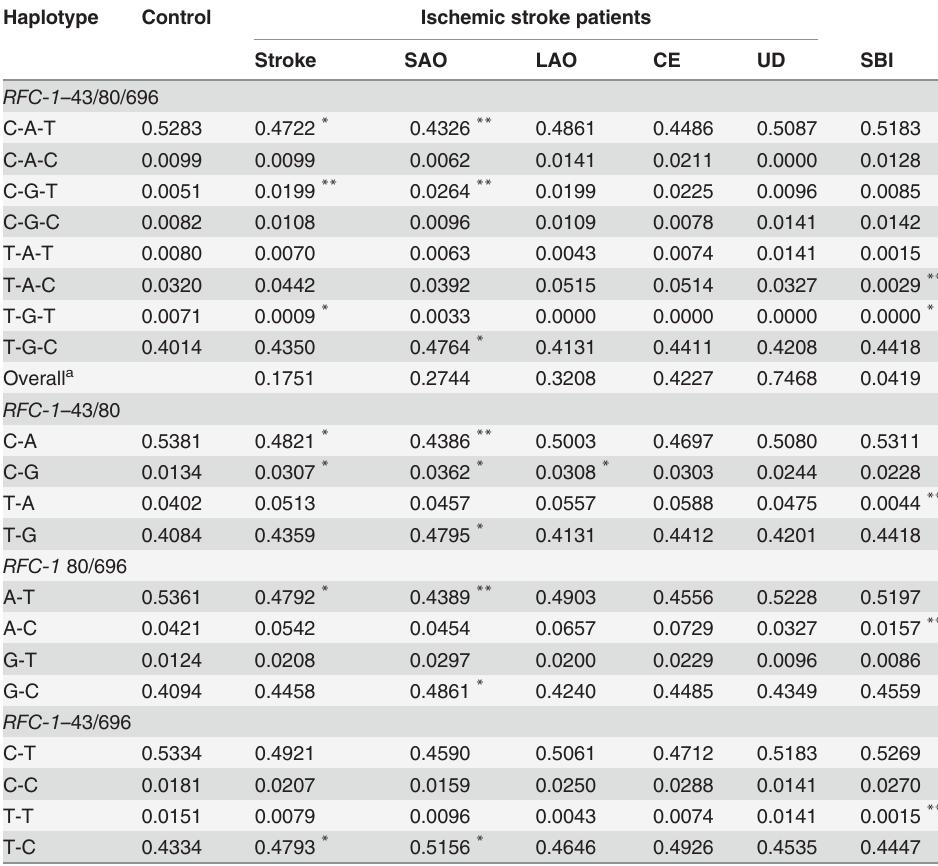
Table 4. The haplotype analysis of the RFC-1 -43C > T, 80A > G, and 696T > C polymorphisms among the ischemic stroke patients, silent brain infarction (SBI) patients, and control